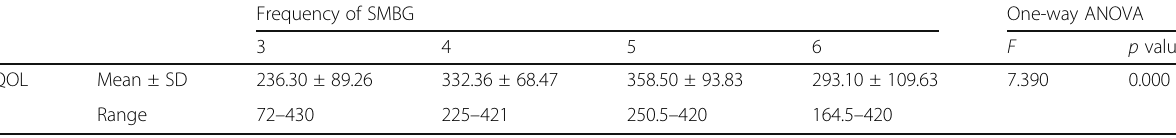
Table 5 Relation between frequency of SMBG and quality of life of adolescent patients Frequency of SMBG One-way